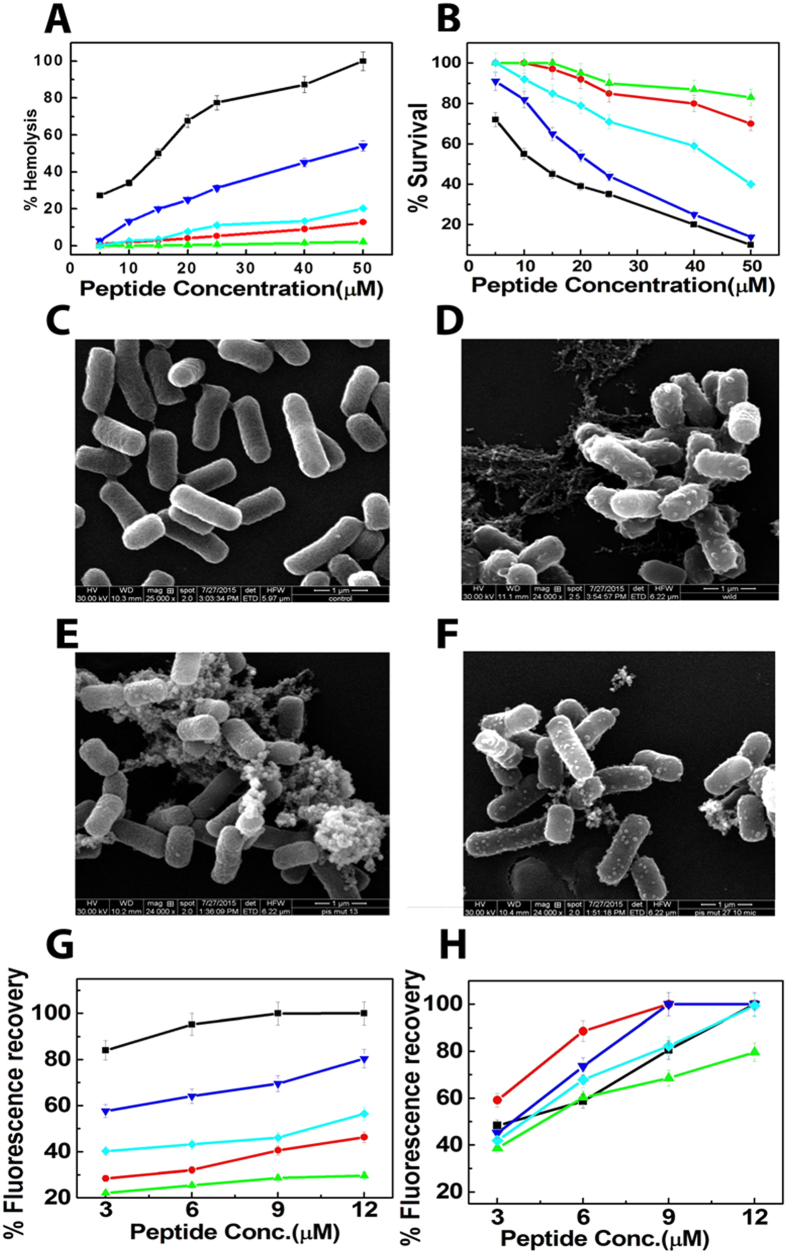
(A) and (B) Show the dose-dependent hemolysis of hRBCs and viability of murine 3T3 cells respectively in the presence of piscidin-1 and its analogs. (C to F) Scanning Electron Microscopy of E. coli ATCC 25922 in the absence and presence of piscidin-1 and its selected analogs; bacteria without any treatment (C), Bacteria after treatment with piscidin-1, T15,21 K piscidin-1 and T15,21dK piscidin-1 at 10 fold MIC of the respective peptide (D,E and F). (G) and (H) Show the plot of fluorescence recovery which is a measure of peptide-induced membrane permeabilization vs peptide concentration (μM) in mammalian and bacterial membrane mimetic PC/Chol (8:1, w/w) and PC/PG (3:1, w/w) lipid vesicles respectively. Symbols: Black square, piscidin-1; Red circle, T15,21K-piscidin-1; Green up triangle, T15,21dK-piscidin-1; Blue down triangle, T15K-piscidin-1 and Cyan diamond, T15dK-piscidin-1. Each data point is an average of three independent experiments and error bar represents the standard deviation.